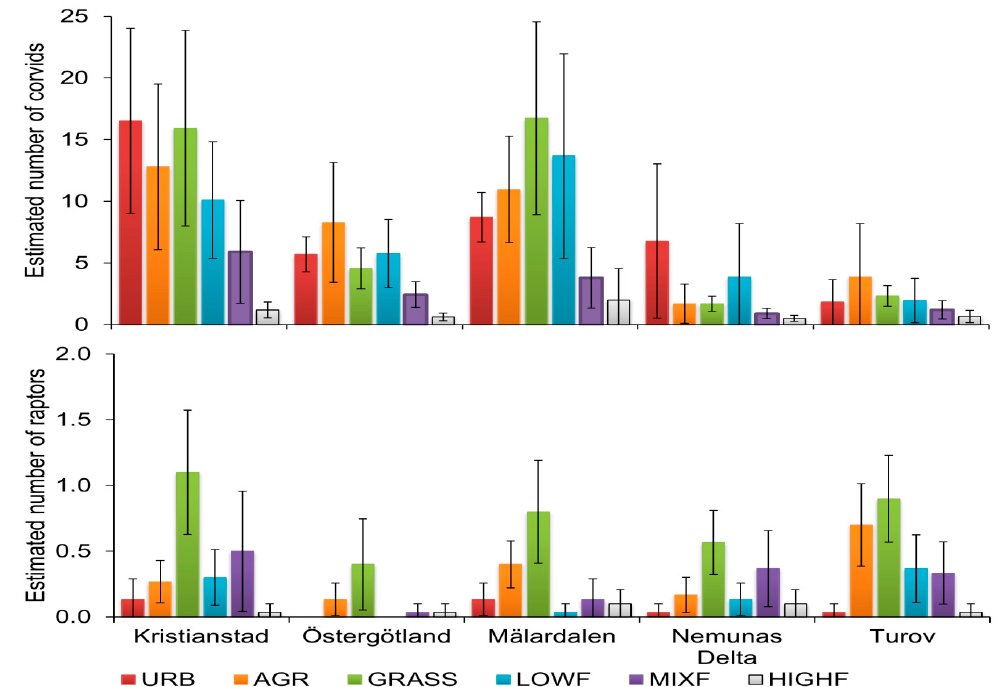
Figure 3. Mean number of corvid (top) and raptor (bottom) observations per point with 95% confidence intervals among the 6 landscape strata; urban area (URB), agricultural land (AGR) (forest cover <5%), semi-natural grassland (GRASS), low forest (LOWF) (cover 5–20%), mixed forest and agricultural land (MIXF) (forest cover 40–60%) and high forest cover (HIGHF) (80–95%) in the five case study landscapes in Sweden (Kristianstad, Östergötland and Mälardalen), Lithuania (Nemunas Delta) and Belarus (Turov).